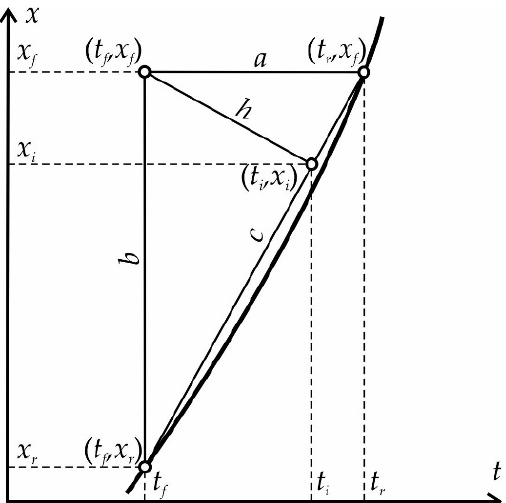
Figure 1. Geometric constructions used to calculate the shortest distance h from the factual point ( t f , x f ) to the calculated curve and determine the coordinates of the point ( t i , x i ) on the calculated curve closest to this factual point. For explanations, see the text.